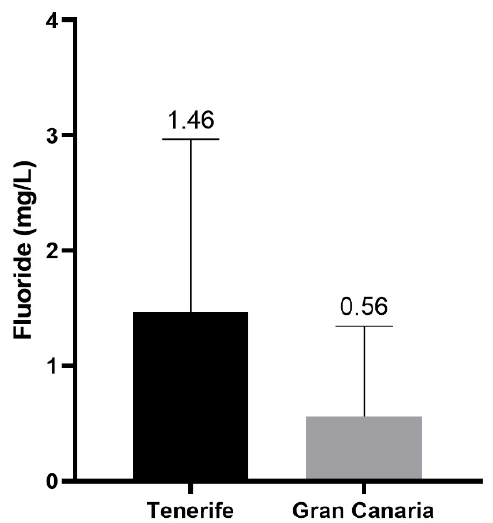
Figure 6. Fluoride content (mg/L) in the Tenerife and Gran Canaria’s islands